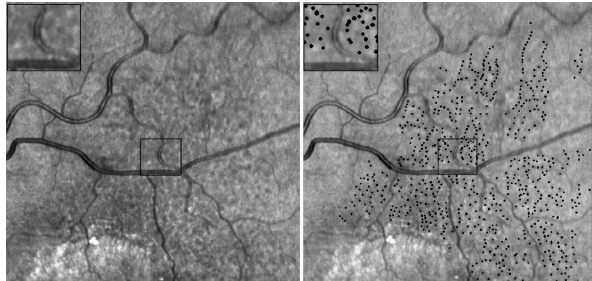
Figure 1. Infrared reflectance (IR) image of lesions: IR image (left), Reticular pseudodrusen (RPD) lesions highlighted by a masked retinal specialist using ImageJ software (NIH, Bethesda, MD) with inset of the area providing a magnified view (1a, right).